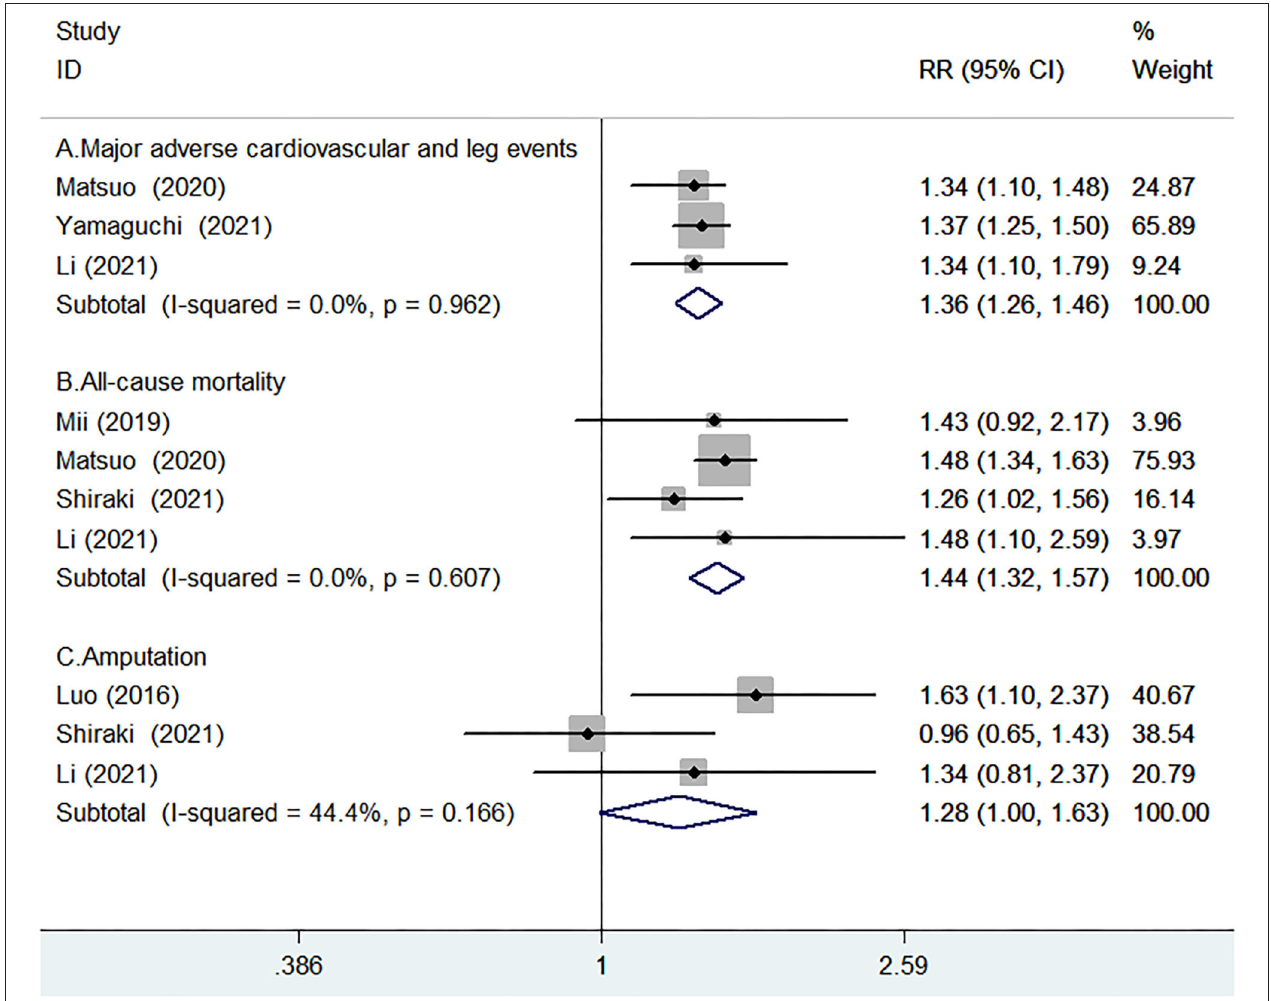
FIGURE 3 | Forest plots showing pooled RR with 95% CI of major adverse cardiovascular and leg events (MACLEs) (A) , all-cause mortality (B ), and amputation (C) for per-10-units Geriatric Nutritional Risk Index (GNRI) score